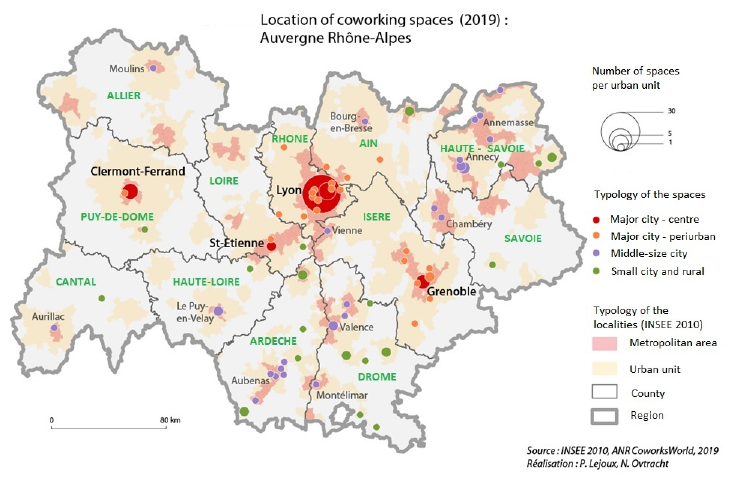
Figure 1: Location of coworking spaces in Auvergne-Rhˆone-Alpes